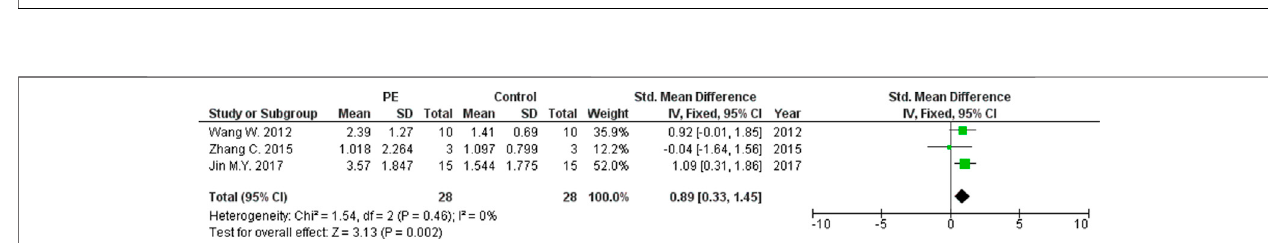
FIGURE 2 | Meta-analysis of differences in expression level of miRNA-16 in placenta between women with vs. without preeclampsia.